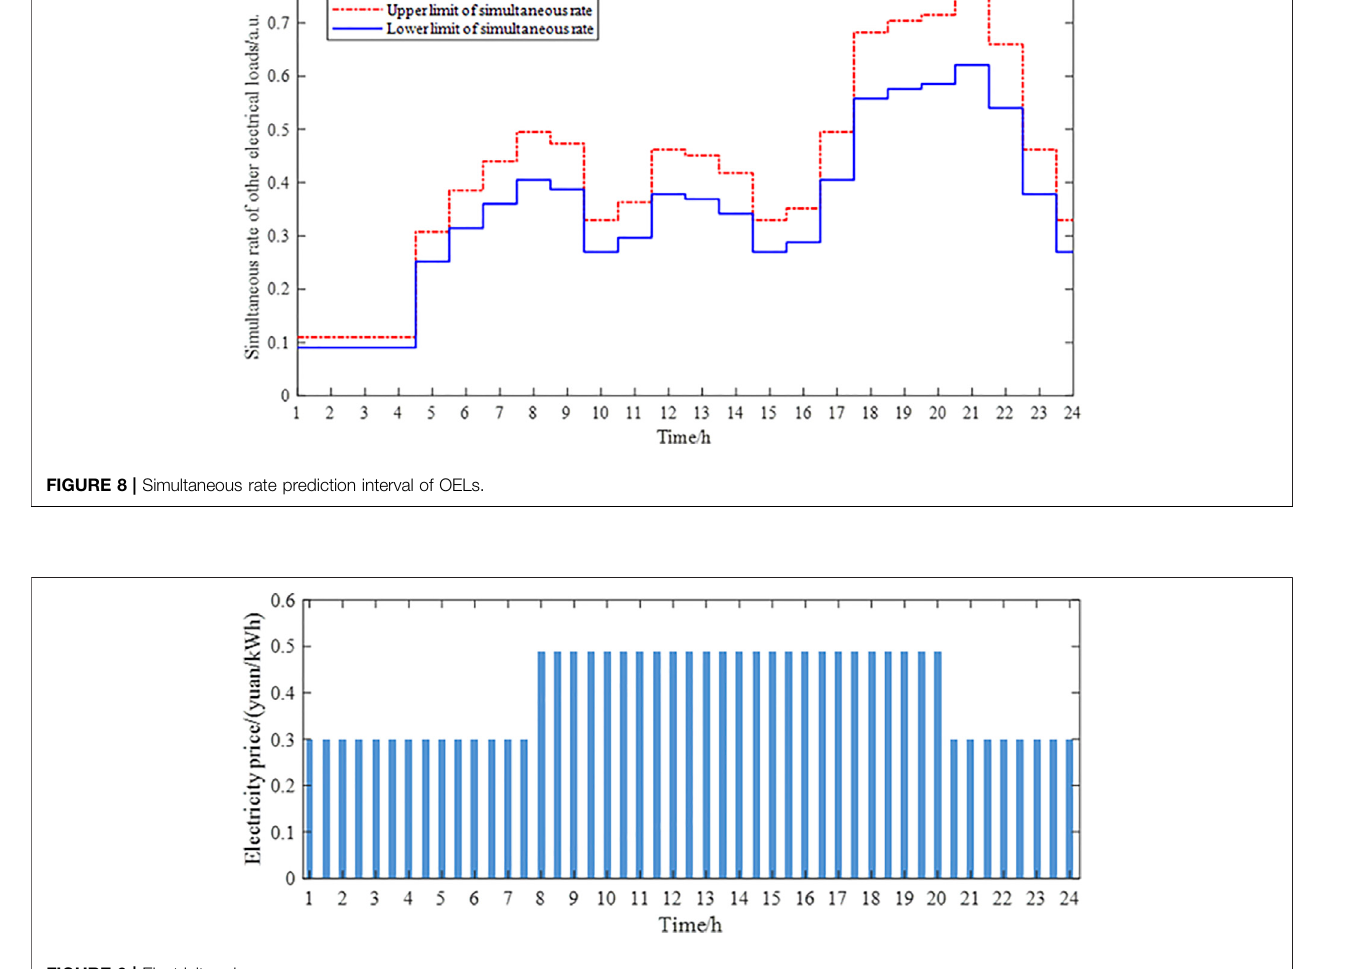
FIGURE 9 | Electricity price.